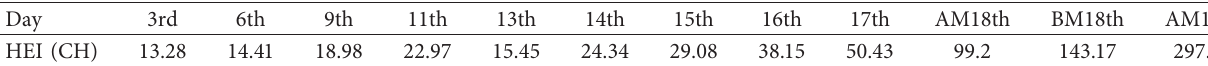
Table 4: Health evaluation indicator (HEI) of each time point.